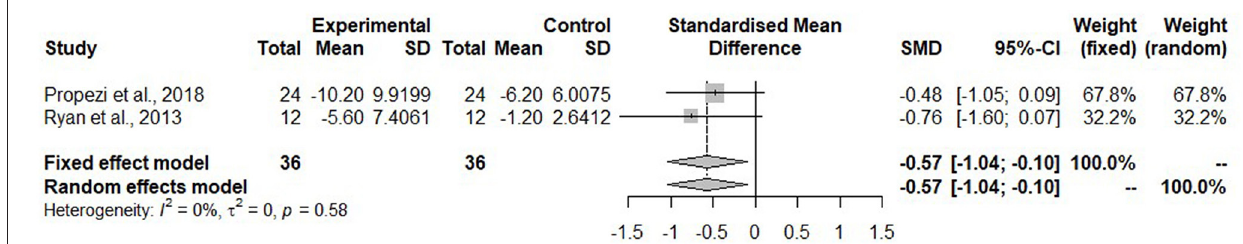
FIGURE 2 | Forest plot of intrahepatic liver fat (IHL); SD, standard deviation; SMD, standard mean difference.